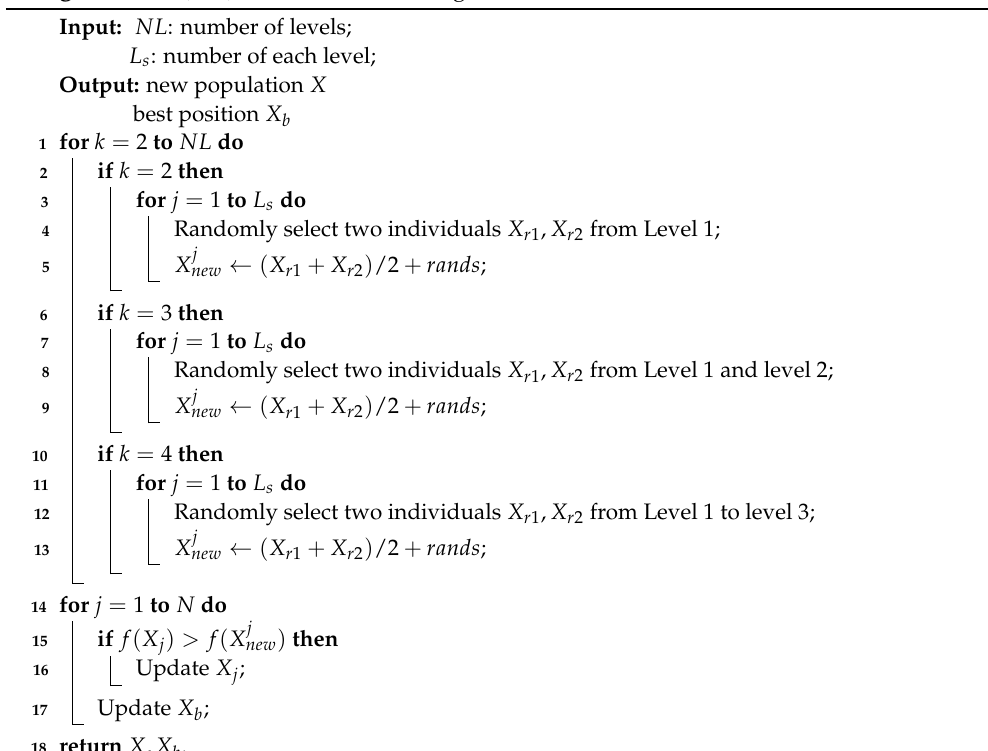
Algorithm 2: (LBl)Level-based learning